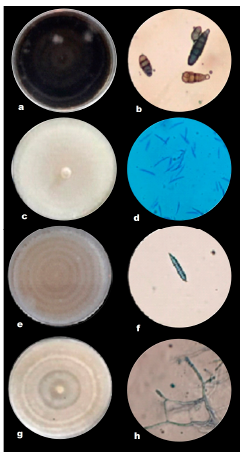
Figure 1. ( a ) Alternaria alternata in Petri dish; ( b ) Alternaria alternata conidia under microscope; ( c ) Fusarium sp. in Petri dish; ( d ) Fusarium sp. conidia; ( e ) Fusarium oxysporum in Petri dish; ( f ) Fusarium